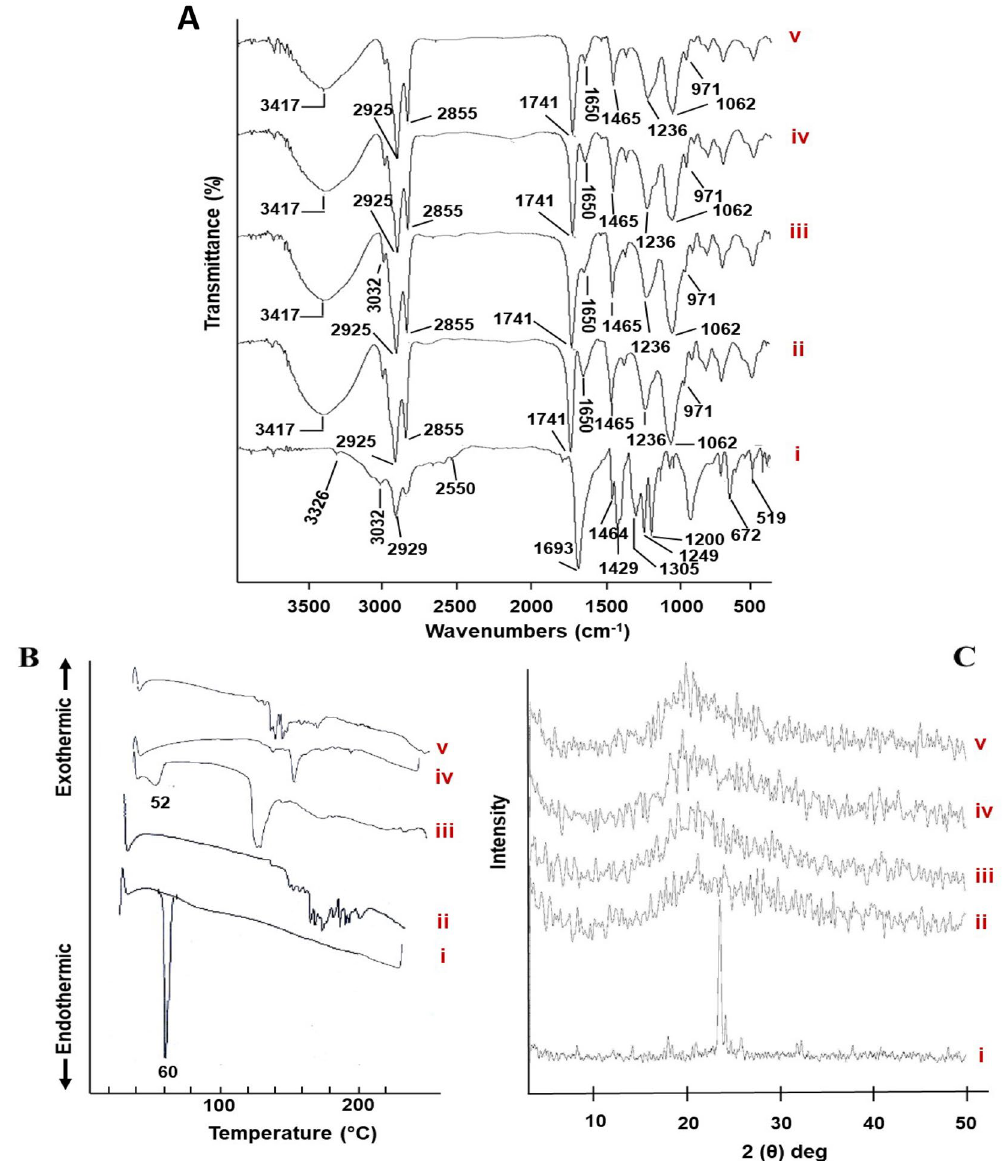
Figure 3. Solid characterization. ( A ) FT-IR spectra, ( B ) DSC thermograms, and ( C ) XRD patterns of pure ALA (i), SL (ii), physical mixture of ALA and SL (iii), NLPs free (iv) and